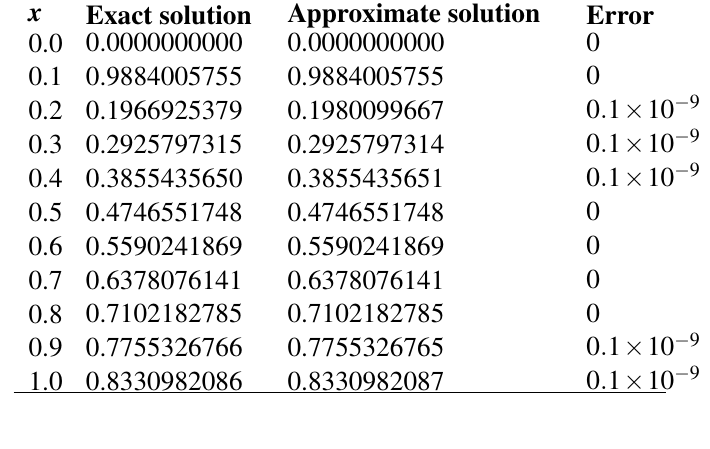
Table 2 Exact solution, approximate solution, and error values for t = 0 . 01